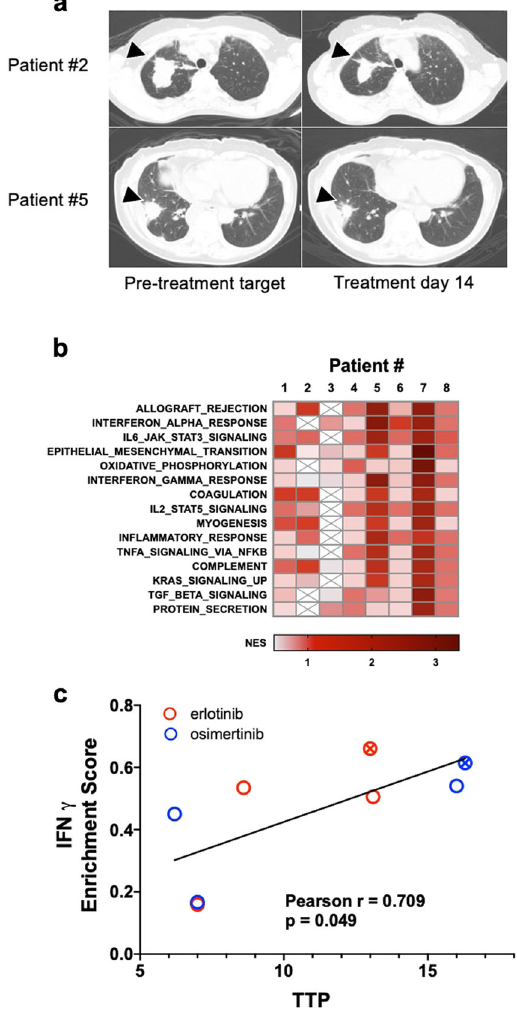
Fig. 4 Enrichment of interferon response and in fl ammation- associated gene sets correlates with progression free survival in human lung tumor biopsies. Lung tumor biopsy specimens from eight EGFR mutant lung cancer patients were collected prior to treatment (baseline) and after 2 weeks of treatment with an EGFR TKI (re-biopsy). a Representative CT images of two patients acquired pre-treatment and at re-biopsy are shown. The arrowheads indicate the lesion that underwent biopsy prior to and on treatment with EGFR TKIs. b Following RNAseq analysis of RNA puri fi ed from the biopsies, GSEA was performed using the Hallmark MSigDB gene sets. The mean Normalized Enrichment Scores (NES) for each Hallmark across the 8 biopsy pairs were used to rank the gene sets and the top 15 are presented as a heatmap (the full analysis is provided in Supplementary Table S2). The data are from one distinct sample per biopsy. c Pearson correlation analysis was used to compare the enrichment scores from the 50 Hallmark gene sets with the TTP for the 8 patients. The full analysis is presented in Supplementary Table S3. The patient biopsies from the two EGFR- L858R tumors are indicated with a circle containing an “ x ”